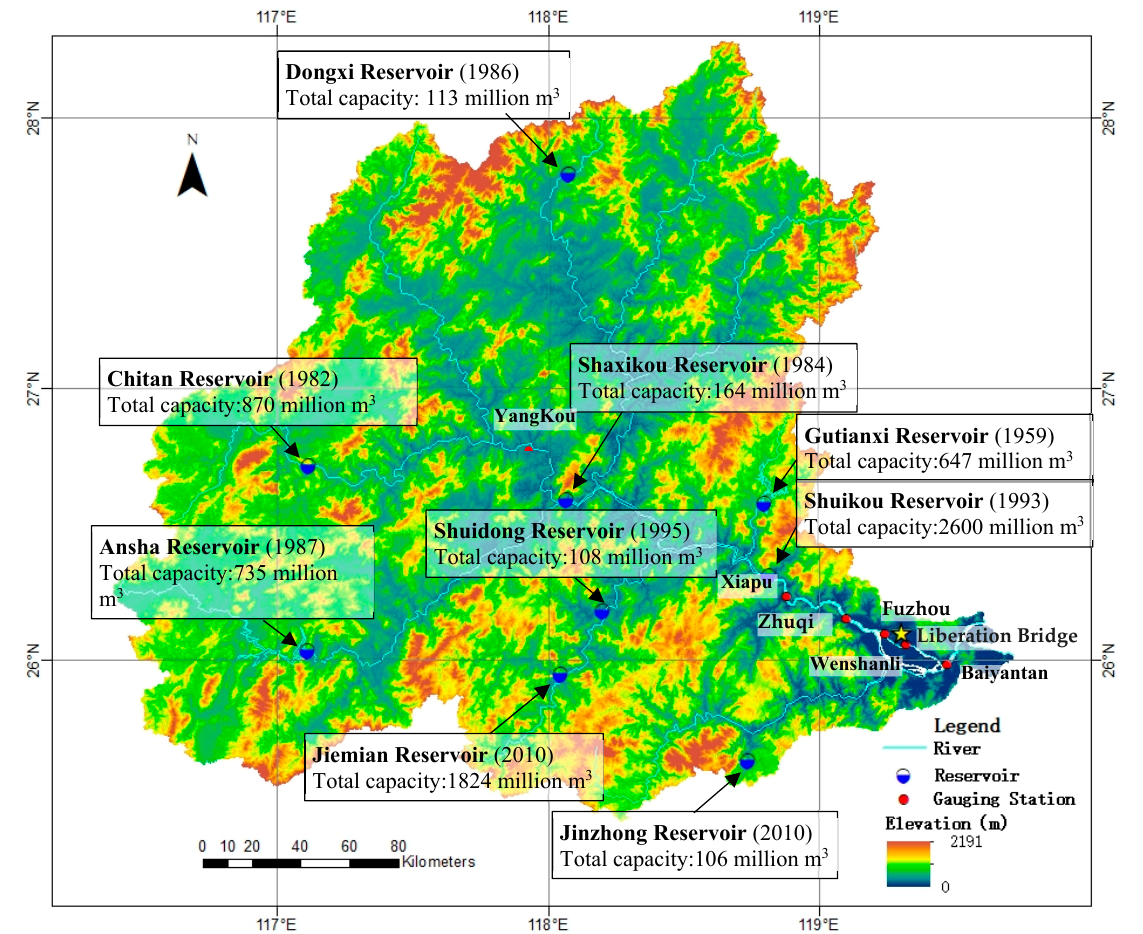
Figure 1. The elevation of the Min River basin and locations of major reservoirs and hydrologic gauging sites.